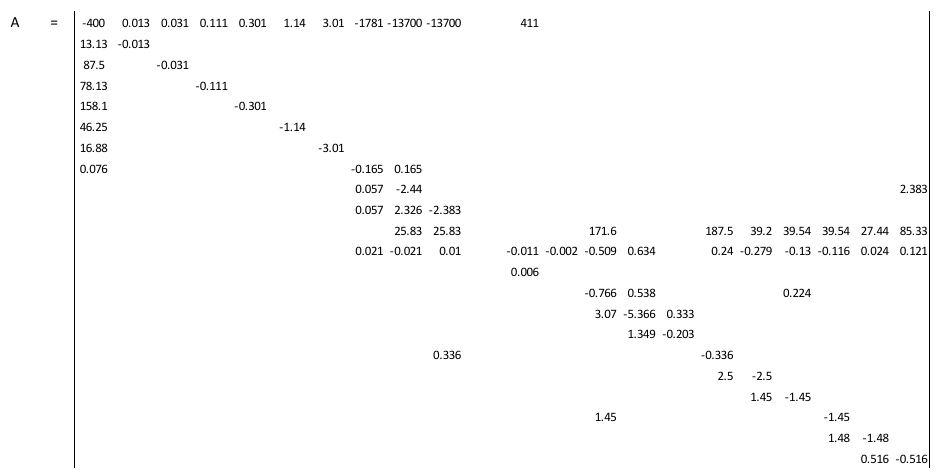
Figure 11. Matrixes X , U , and B for the State = Space system. The matrixes A represent the constants of each equation related to the output variables, and it is presented in Figure 12.